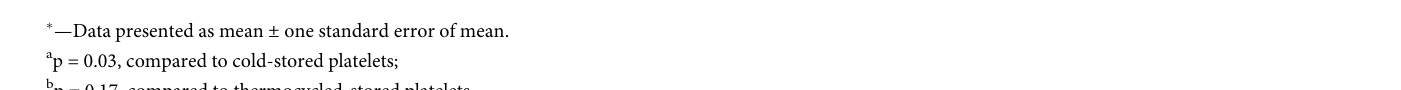
Table 3. Recovery and survival of human platelets following storage at different conditions and transfusion into SCID mice � . Storage condition Survival (area under the curve) � —Data presented as mean ± one standard error of mean. a p = 0.03, compared to cold-stored platelets; b p = 0.17, compared to thermocycled-stored